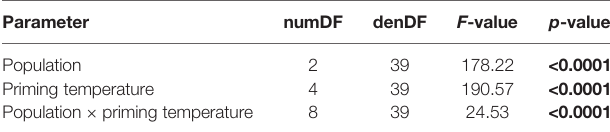
TABLE 2 | Two-way ANOVA to examine the effects of priming temperature and population on the sporophyte formation of Laminaria digitata gametophytes from Tromsø, Roscoff and Quiberon on day 28 during experiment 1.